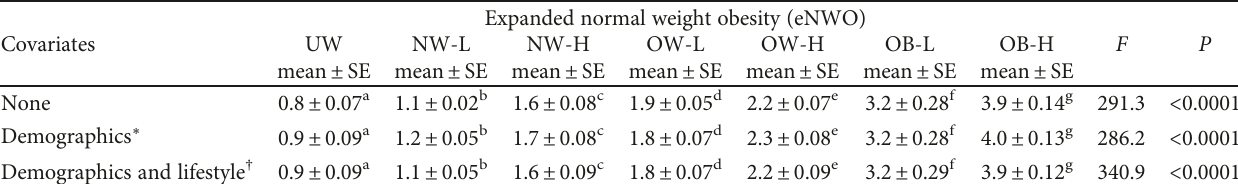
Table 3: Mean di ff erences in HOMA-IR across the expanded normal weight obesity (eNWO) categories, adjusted for covariates. Covariates